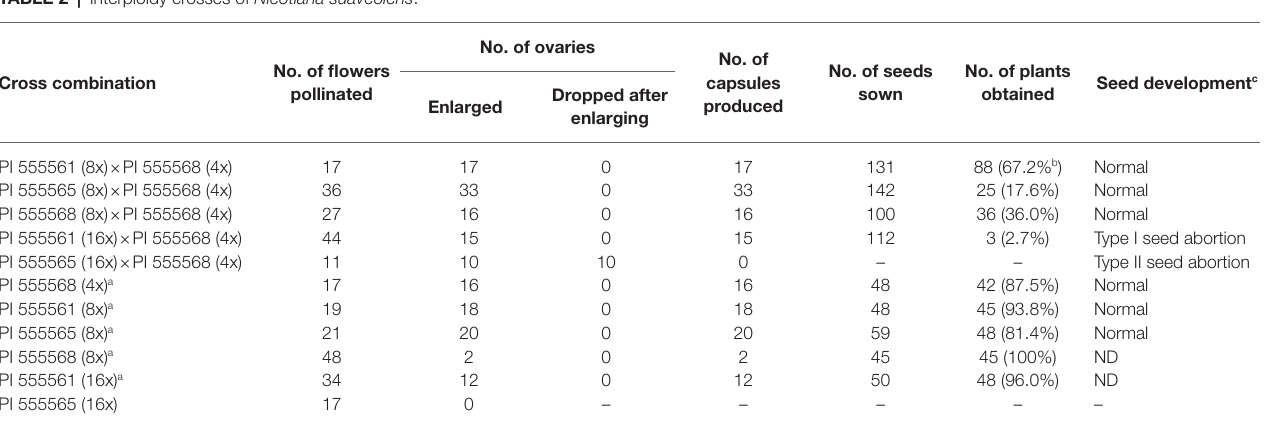
TABLE 2 | Interploidy crosses of Nicotiana suaveolens .